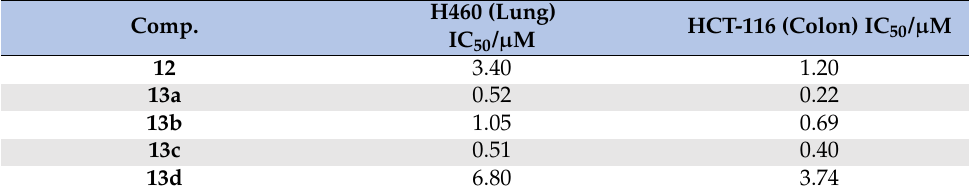
Table 4. In vitro cytotoxic activity (IC 50 ) of macrocycles 13a ~ 13d [42].